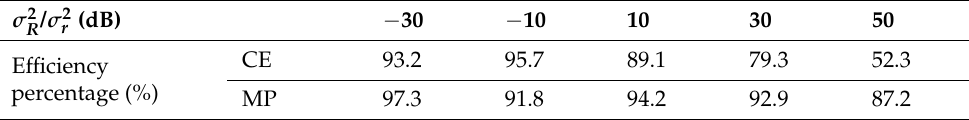
Figure 3. Performance of a far acoustic target and a near calibration source. Table 1. Efficiency percentage of CE and MP methods (Simulation 1).